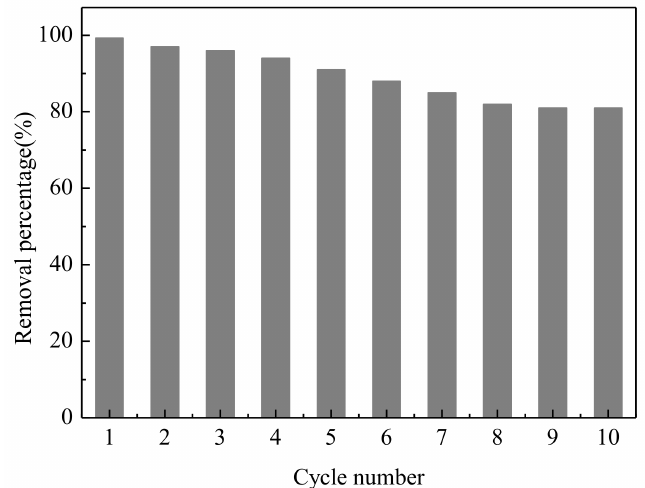
Figure 8. The removal percentage of RhB solution using recyclable BN sample within 10